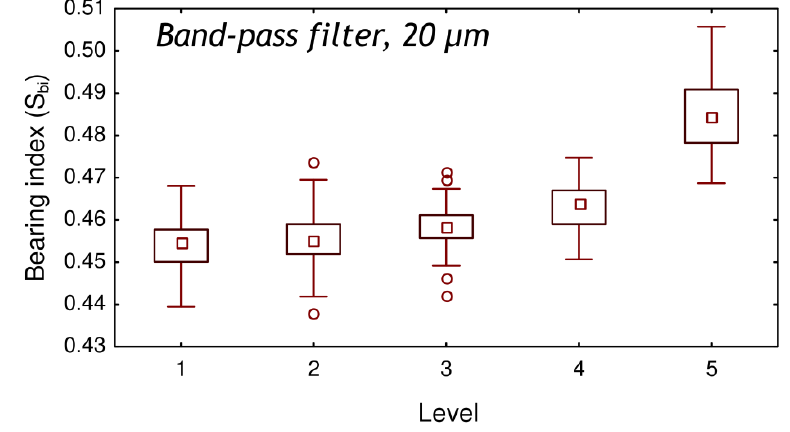
Figure 3. Bearing index S bi values obtained with a band-pass filter with a cut-off of 20 µm and a bandwidth of 5 µm as a function of the visual roping levels, after tensile testing.